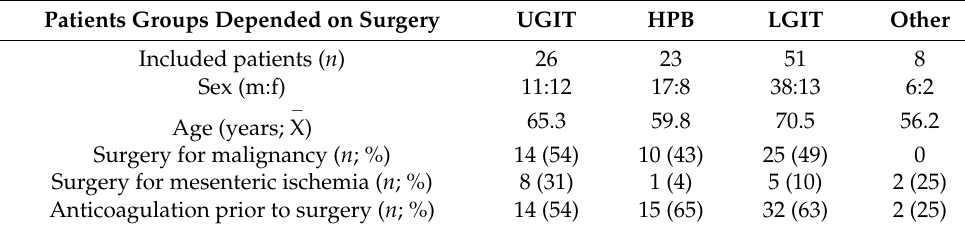
Table 3. Patient’s characteristics. Patients Groups Depended on Surgery